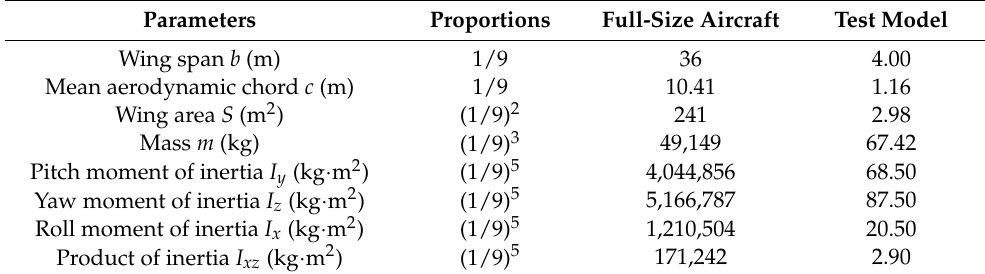
Figure 12. Scaled model in the FL-10 low-speed wind tunnel. Table 3. Design parameters of the test model.